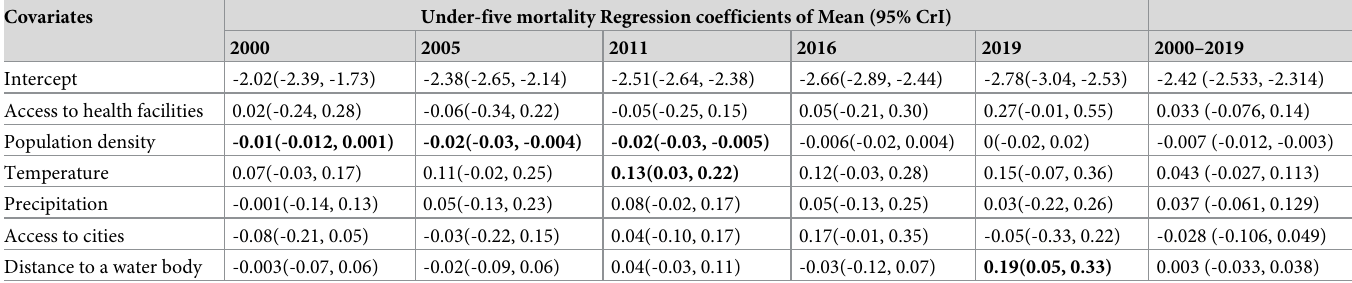
Table 3. Regression coefficient mean and 95% credible intervals (CrI) of covariates included in a Bayesian spatial model with binomial response for the under-five mortality in Ethiopia between 2000 and 2019. Covariates Under-five mortality Regression coefficients of Mean (95%